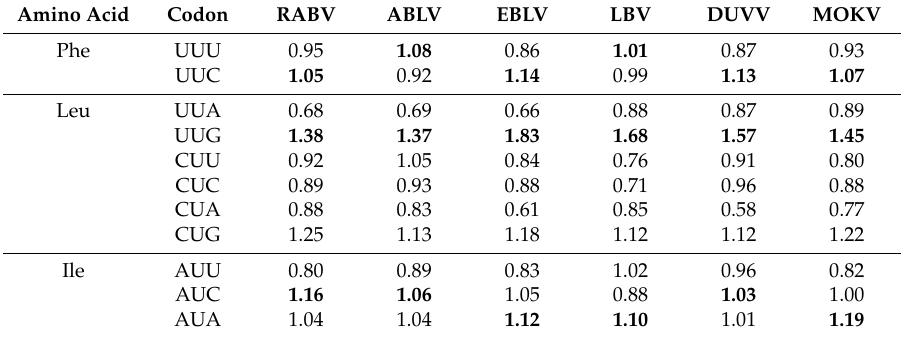
Table 1. The relative synonymous codon usage (RSCU) patterns of lyssaviruses. Amino Acid